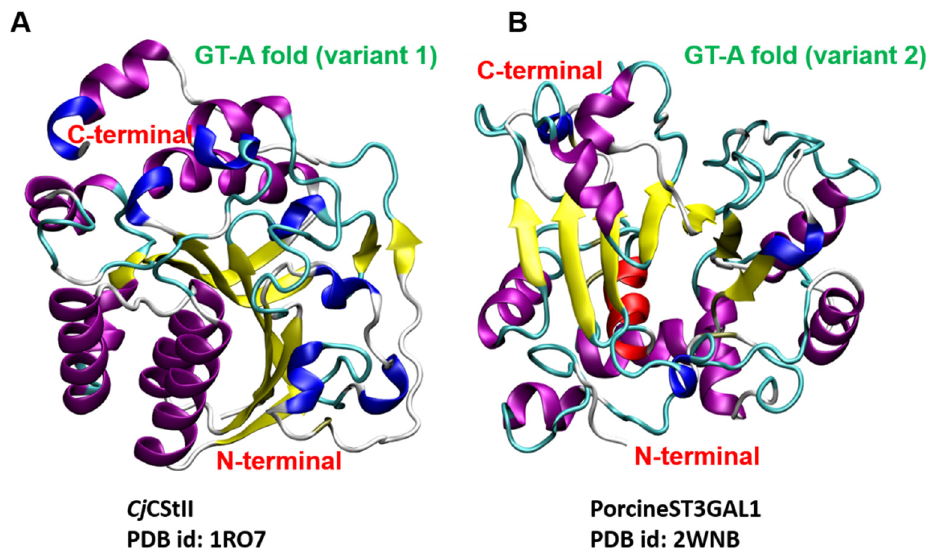
Figure 3. Representative glycosyltransferase global folds. ( A ) GT-A (variant 1) fold correspondingto C. jejuni CstII (PDB id: 1RO7); ( B ) GT-A (variant 2) fold corresponding to porcine ST3GAL1(PDB id: 2WNB).